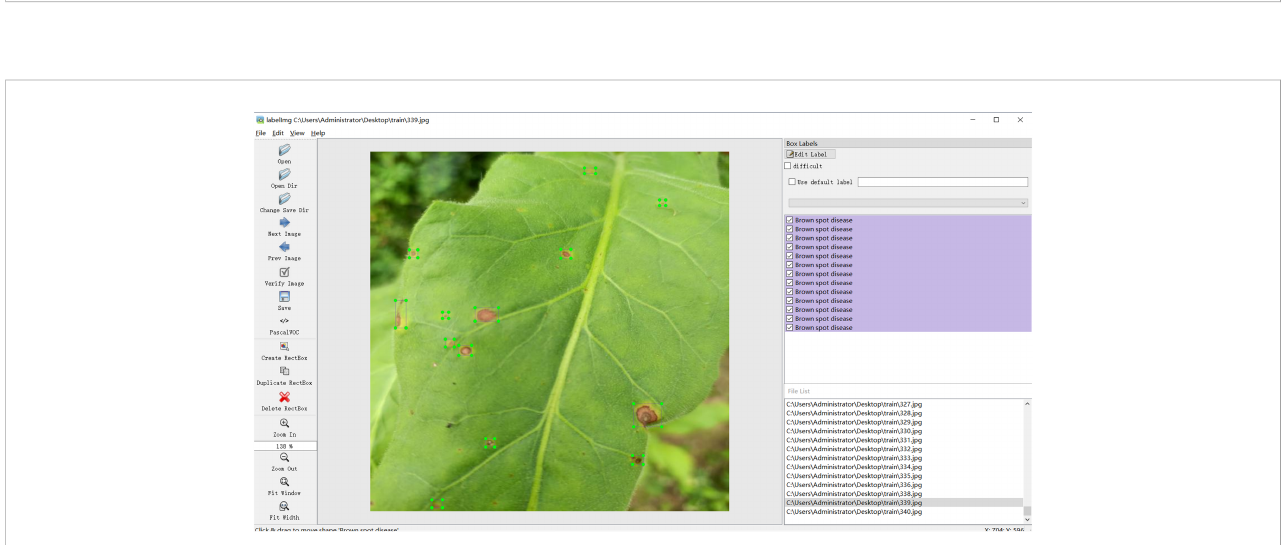
FIGURE 2 Process of tobacco brown spot disease symptom labeling with